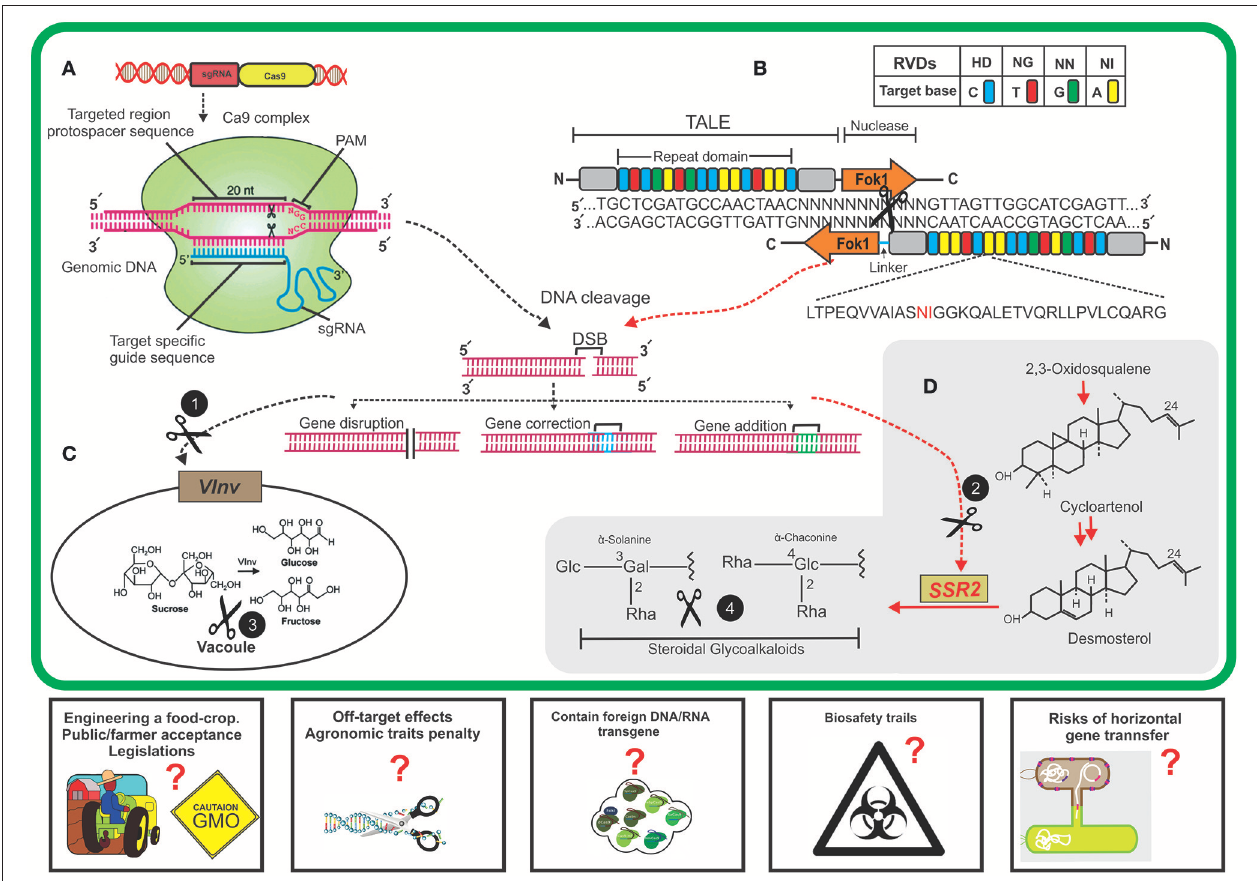
FIGURE 1 | A schematic diagram of new breeding technologies (NBTs) application for editing potato genome for nutritional improvement. (A) Clustered regularly interspaced short palindromic repeat/CRISPR associated9 (CRISPR/Cas9) system. Expression of constructs containing a single guide RNA (sgRNA) and Cas9 endonuclease will result in the assembly of sgRNAs and Cas9 nuclease to make a sgRNA/Cas9 complex. The designed sgRNA having sequence complementarity will bind specifically to a targeted site on genomic DNA and sgRNA/Cas9 complex will cleave 3’ upstream of PAM (protospacer adjacent motif) sequence; shown by black scissors. This cleavage will result in double-stranded brakes (DSB) in targeted genome. (B) Transcription activator-like effector nucleases (TALENs) system. The TALE array contains a highly conserved (33–34 nt) DNA binding domain having repeat variable di-residues (RVDs) at positions 12 and 13 to guide the target-specific binding. Nuclease activity is performed by domains containing FokI endonucleases to produce DSBs. These DSBs are normally repaired by host-mediated DNA repair mechanisms which might results in targeted mutation and end in either gene disruption, correction or addition. The black circles having white text (1,2) represent the CRISPR/Cas9/TALENs cleavage of two host genes (vacuolar invertase, VInv ; sterol side chain reductase, SSR2 ). (C) VInv is primarily involved in bioconversions of sucrose to fructose and glucose inside cell vacuole, precursors of acrylamide formation. (D) Biosynthesis of steroidal glycoalkaloids in plant cell from cycloartenol which is mediated by the activity of host SSR2 gene. NBTs-mediated targeting of host genes will result in reduced formation of anti-nutrients (acrylamide and steroidal glycoalkaloids) inside tubers and thus result in the improved quality of potato tubers. The proposed challenges (rectangles) by using these technologies might result in some questions such as society and regulation regimes’ approval for editing food crop, off-site targeting effects on plants, the presence of any transgene, biosafety trails to check health-related issues, and the potential risks of horizontal gene transfer by using these GM crops. These questions need to be addressed while before using some